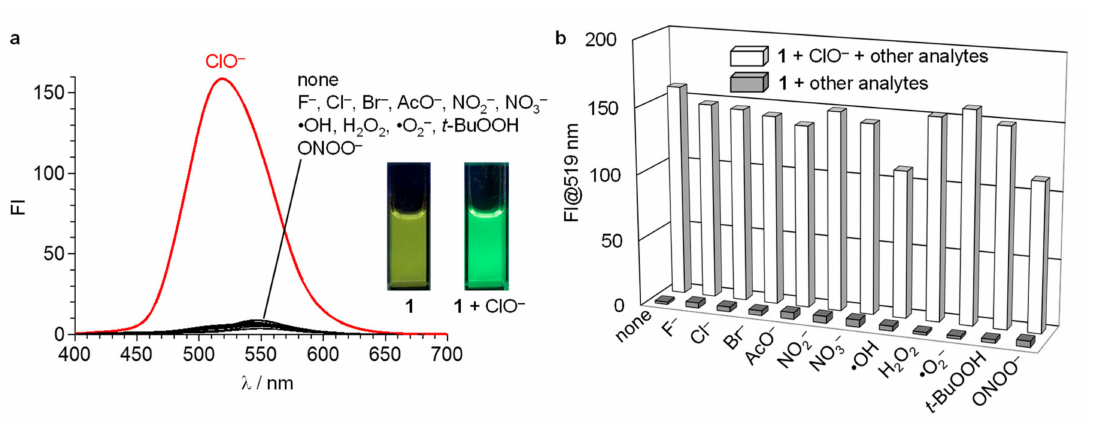
Figure 1. ( a ) Fluorescence spectra of 1 (10 µ M) in a bu ff ered water / MeCN mixture (8 / 2 v / v , pH 7.0) at 25 ◦ C with 50 equiv of each analyte. ( b ) Intensity obtained (grey) with 50 equiv of each analyte and (white) 50 equiv of ClO – and analytes. All spectra were measured after stirring the solution for 10 min. The salts used are: NaF, KCl, NaBr, AcONa, NaNO 2 , and KNO 3 .